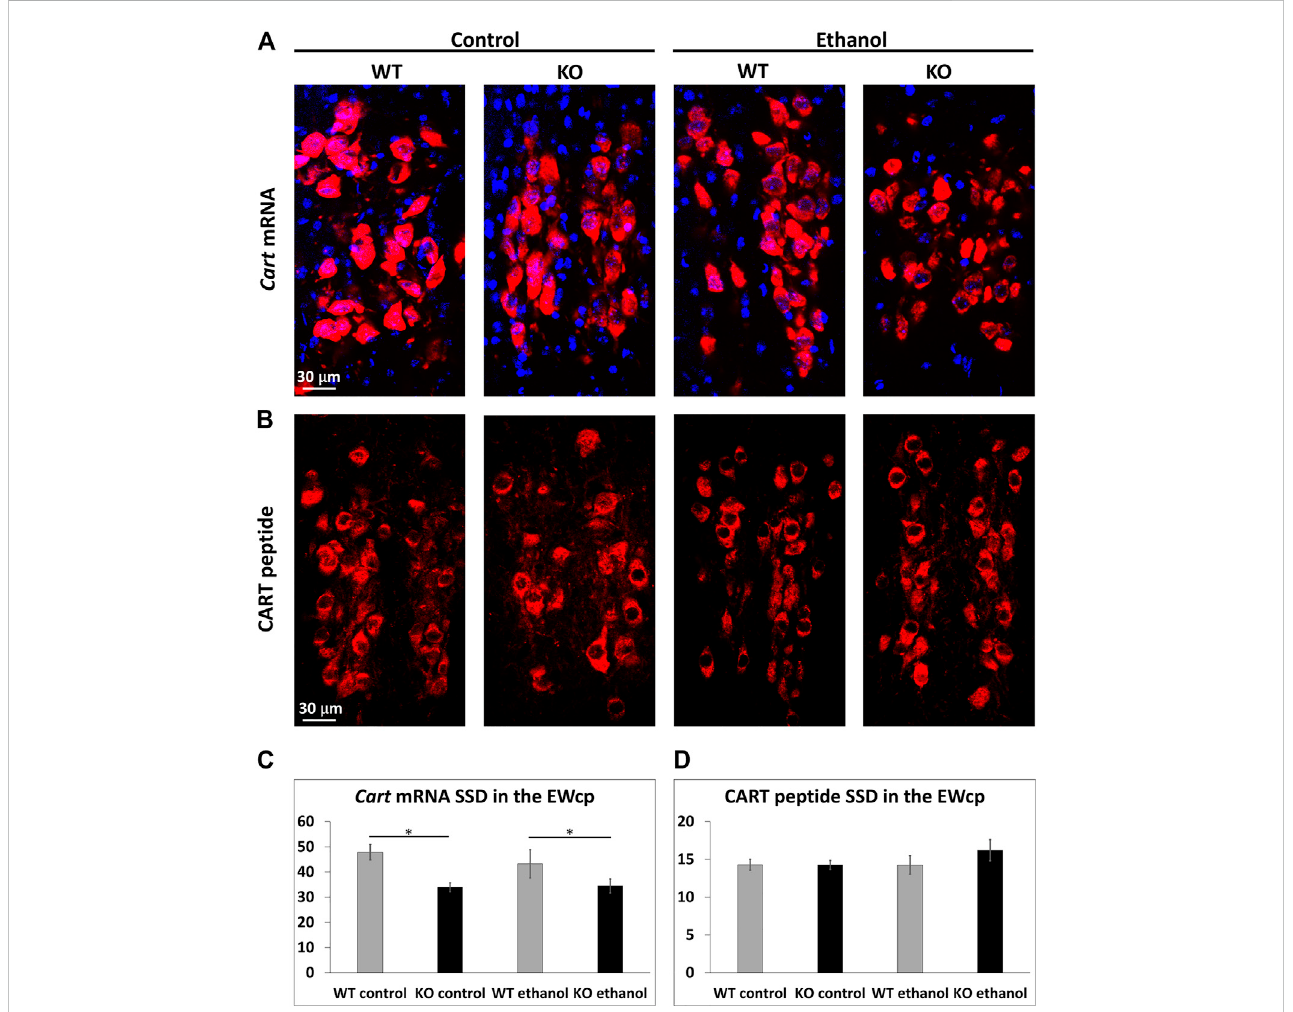
FIGURE 6 CART mRNA and peptide content of the centrally projecting Edinger – Westphal nucleus (EWcp). Representative fl uorescence images showing the expression of cocaine- and amphetamine-regulated transcript ( Cart ) mRNA (red) by RNAscope in situ hybridization (A) and the CART peptide (red) by immuno fl uorescence (B) ,intheEWcpofwildtype(WT)and Trpa1 knockout(KO)mice2 hafteri.p.,saline(control)and1 g/kgethanolinjection.Fornuclei,the sectionswerecounterstainedwith4 ′ ,6-diamidino-2-phenylindole(DAPI)(blue).Quantitativeevaluationof Cart mRNA (C) andCARTpeptide (D) speci fi c signal density (SSD) in the EWcp of WT and Trpa1 KO mice, 2 h after i.p., saline (control) and 1 g/kg ethanol injection. Columns show means ± SEM of Cart mRNA (C) and CART peptide (D) SSD in the EWcp ( n = 6 – 8; * p = .05; two-way ANOVA and Tukey ’ s post hoc